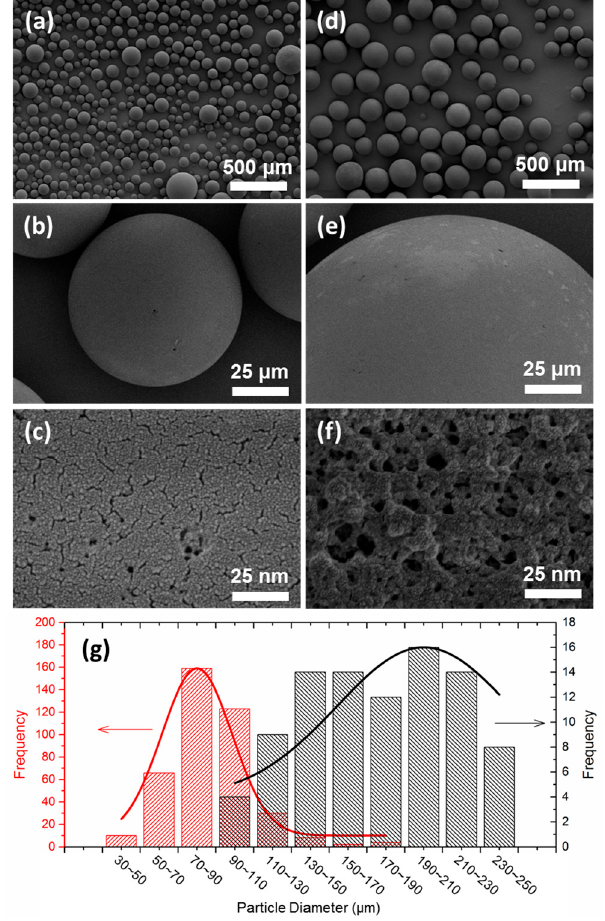
Figure 2. ( a – f ) SEM images of M-PMs ( a – c ) and PMs ( d – f ) at different magnification scales, and ( g ) the particle diameter distribution of M-PMs (red histogram and line) and PMs (black histogram and line).